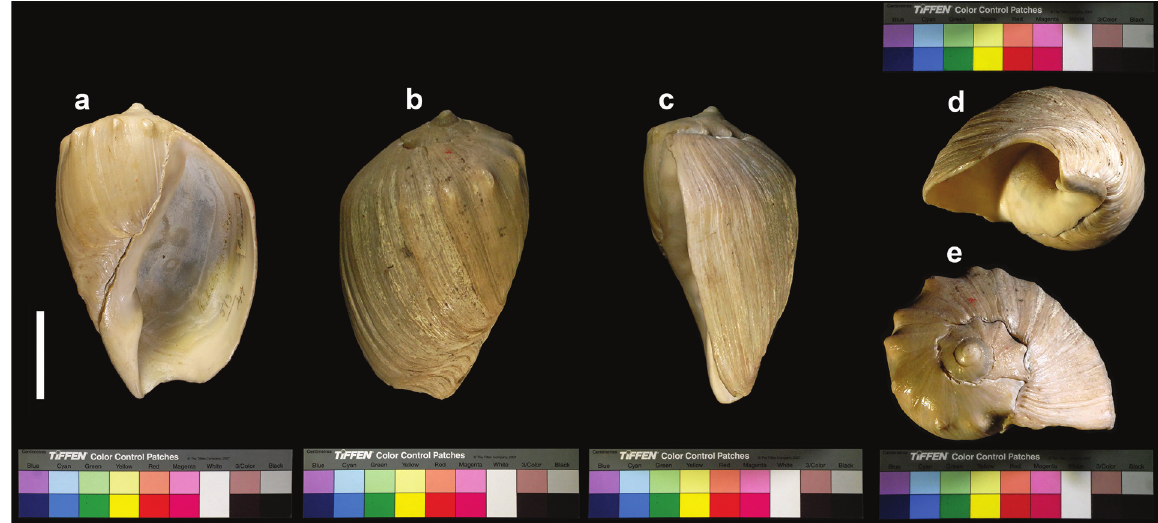
Figure 33. Voluta colocynthis intermedia , specimen figured by Lahille (1895: pl. V, fig. 47) a Apertural view b Dorsal view c Lateral view d Umbilical view e Apical view. Scale bar: 5 cm.